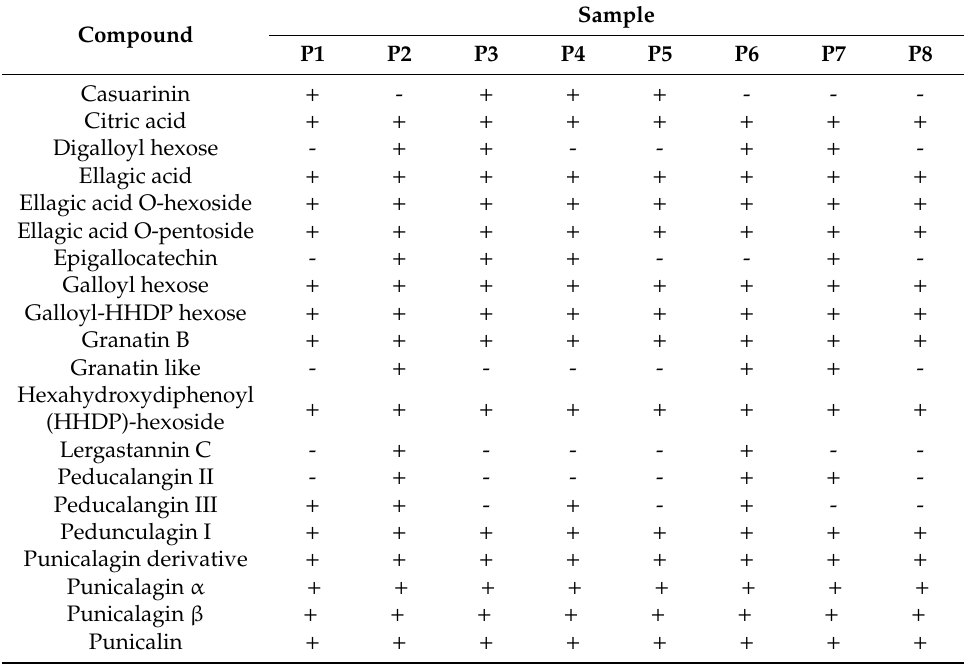
Table 2. Presence of tentatively identified bioactive compounds in eight ethanol pomegranate (Punica granatum L.) peel extracts